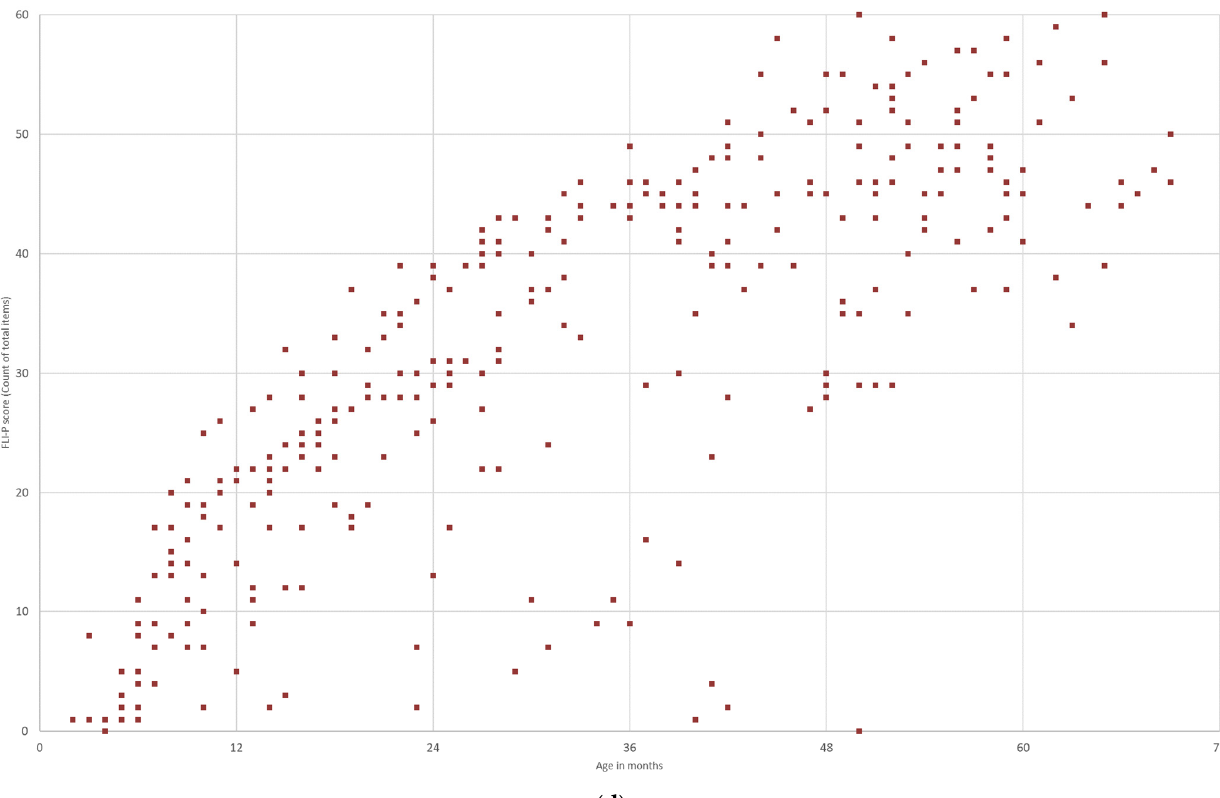
Figure 12. FLI-P scores by ( a ) mild and mild–profound; ( b ) moderate and moderate–severe; ( c ) severe and severe–profound; and ( d ) profound bilateral (no additional